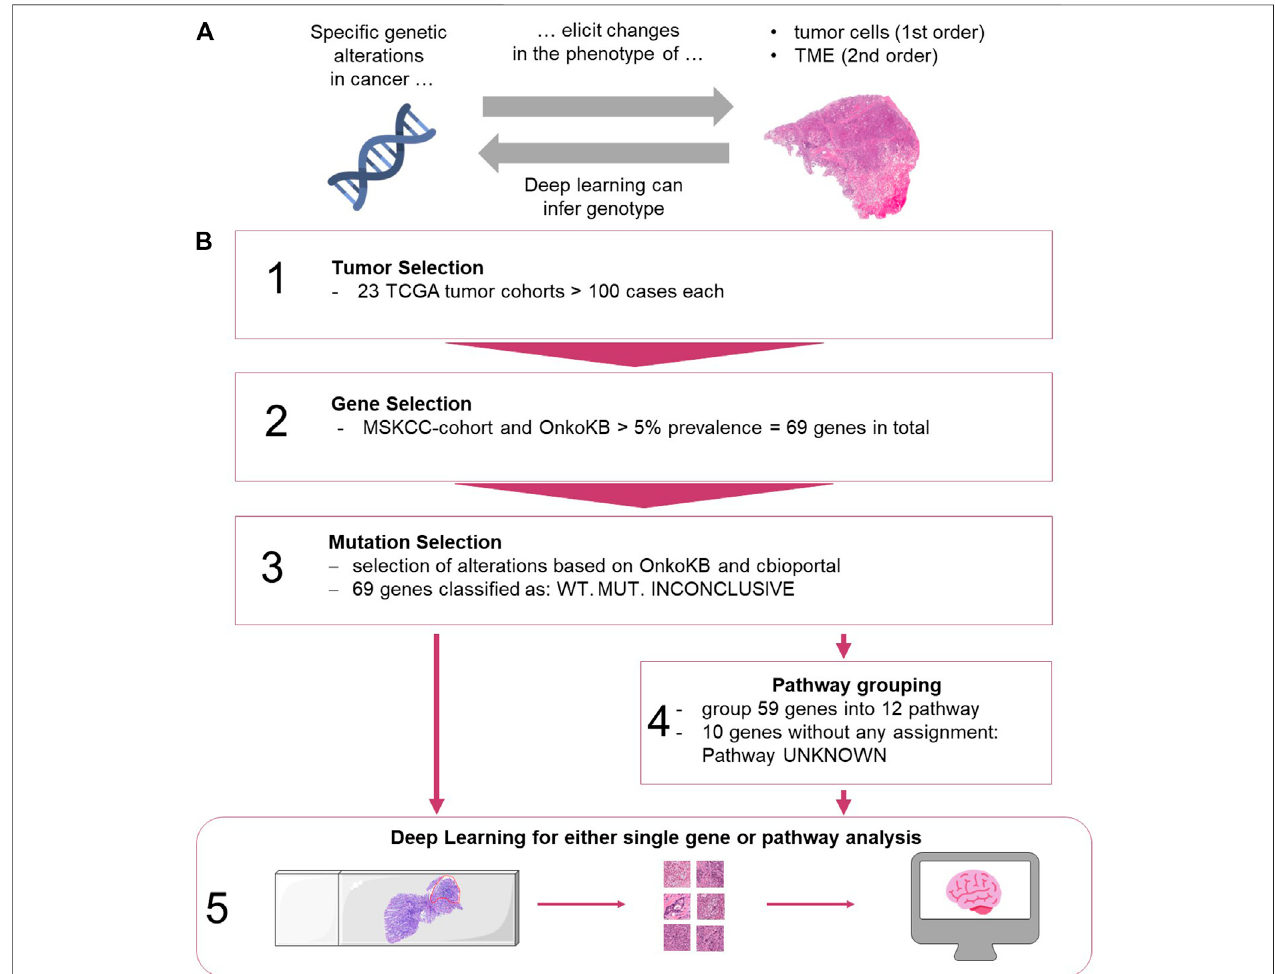
FIGURE1|(A) Biologicalhypothesisofthisstudy.TME:tumormicroenvironment. (B) Work fl owforselectionofdataandDeepLearningmethods. (1) Tumorsfrom TCGAwereanalyzed. (2) GeneswereselectedbasedontheMSKCCcohortandOnkoKBplatforms. (3) Alterationsweregroupedbasedondifferentsources. (4) Genes weregroupedintopathways(see SupplementaryTableS1 ). (5) Processingofimagesandtrainingofthenetworkforgenesaloneandgroupedintopathways.(images from https://smart.servier.com, and Twitter Twemoji under a CC-BY license). TME: tumor microenvironment, TCGA: The Cancer Genome Atlas, MSKCC, OnkoKB, WT: wild type, MUT: mutation